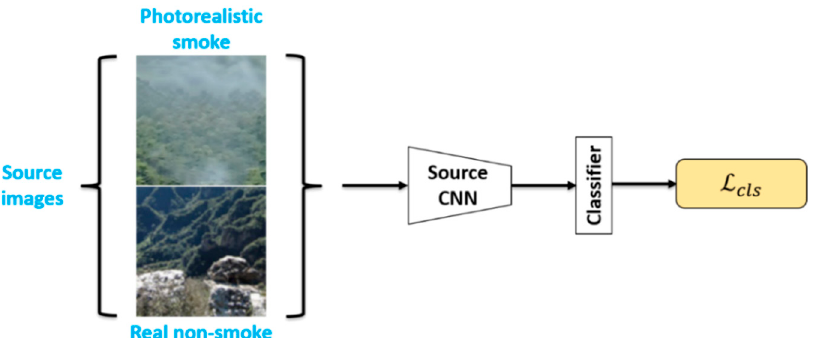
Figure 6. Pre-training phase for feature-level domain adaptation. The input source images in this phase are all labeled.